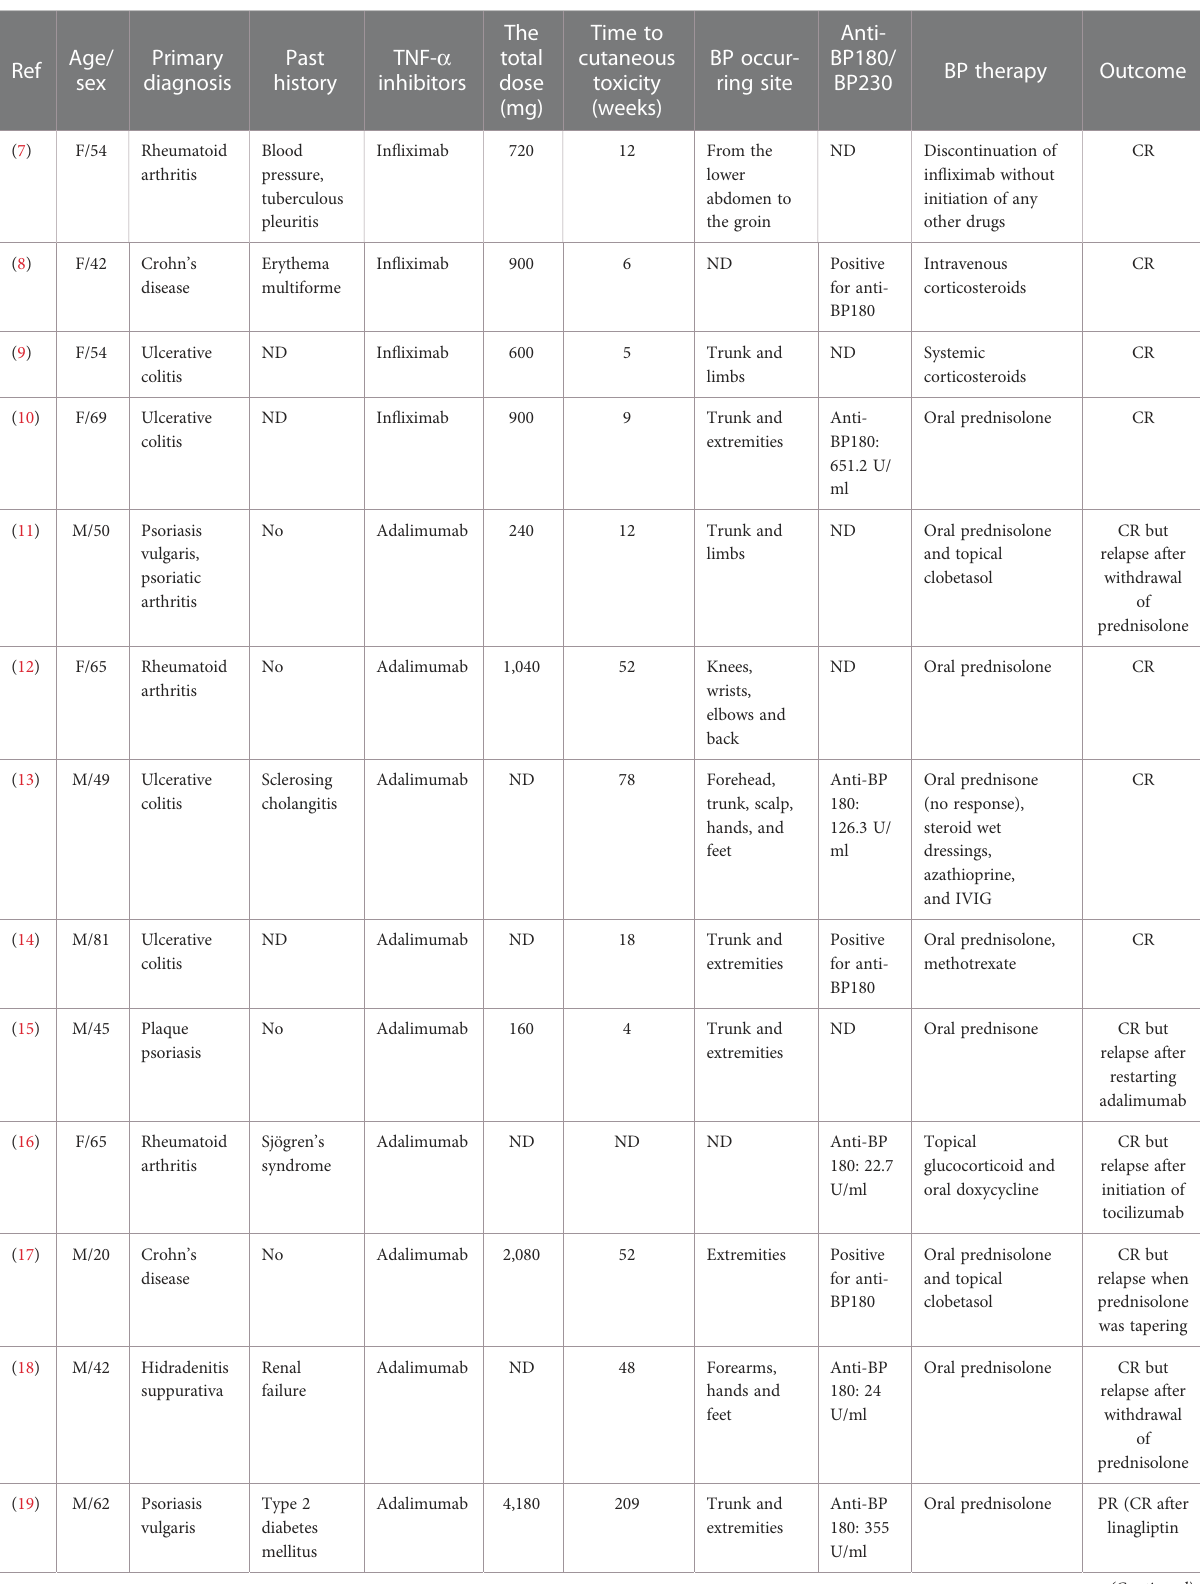
TABLE 1 Clinical characteristics of BP cases associated with TNF- a